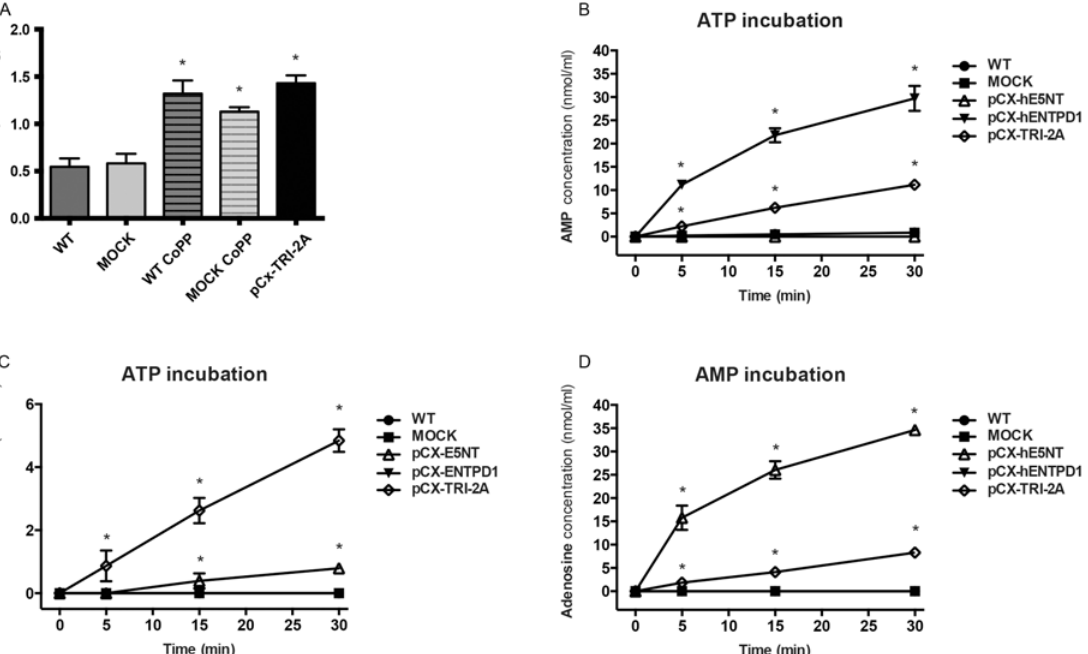
Fig 4. Heme oxygenase-1 and ectonucleotidases functional assays. ( A ) Heme Oxygenase 1 activity assay on NIH3T3 cells. Lysates from WT, mock- and pCX-TRI-2A-transfected cells were incubated for 2 hours with Hemin, BSA, Biliverdin Reductase A in reaction buffer as described in Materials and Methods. As positive control of the assay, wt or mock-transfected cells were pre-stimulated with 50 μ M of HO1 inducer, Cobalt Protoporphyrin for 24 hours (wt CoPP, mock CoPP). Enzymatic activity is reported as nanomoles of bilirubin per hours per milligrams of protein extract. Data are expressed as mean ± SEM of 3 – 4 independent experiments. * p < 0.05 versus wt and mock-transfected cells. (B) ENTPD1-mediated AMP production and (C) E5NT- mediated adenosine production by wild type, mock and pCX-TRI-2A transfected-cells. Cells were incubated with 50 μ M ATP for 30 min. The nucleotide content of supernatants collected at 0, 5, 15, 30 min time points was measured by reverse phase-HPLC as detailed in Material and Methods. Data shown are mean ± S.D. (n = 3). * p < 0.05 versus all groups. (D) E5NT-mediated adenosine production by wild type, mock and transfected-cells. Cells were incubated with 50 μ M AMP for 30 min. The nucleotide content of supernatants collected at 0, 5, 15, 30 min time points was measured by reverse phase-HPLC ad detailed in Material and Methods. Data shown are mean ± S.D. (n = 3). * p < 0.05 versus all groups.